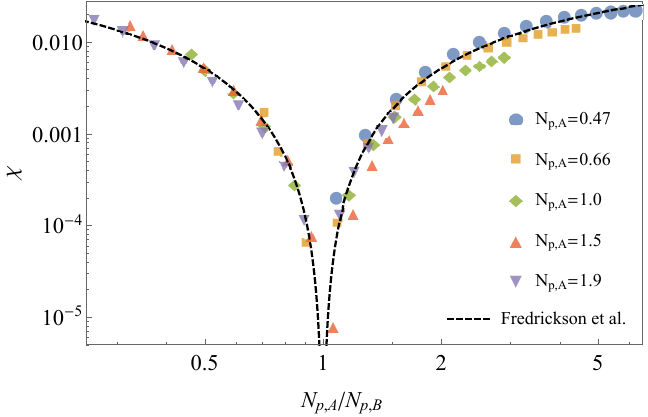
Figure 8. Field theory predictions for χ ([15]) agree rather well with simulation results for semiflexible bead-spring chains using our novel thermodynamic integration